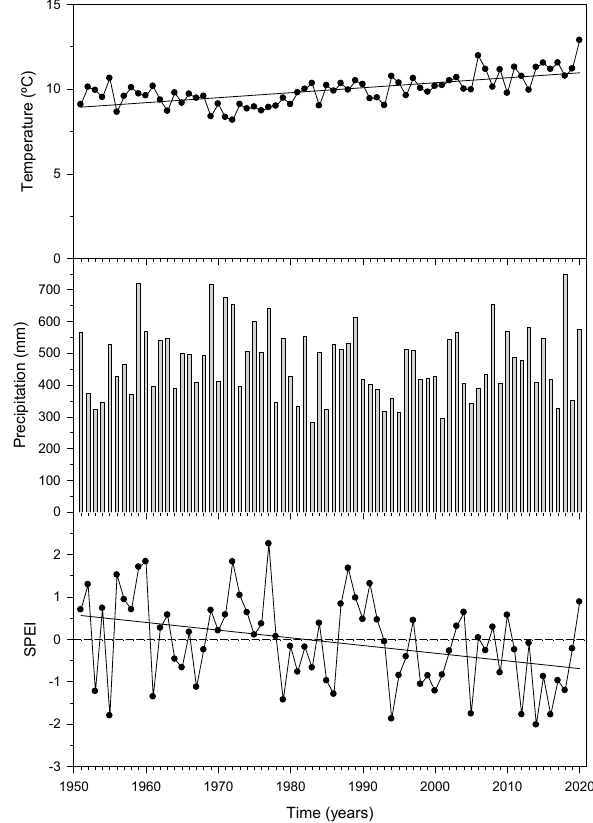
Figure 2. Annual climate (mean temperature and total precipitation) and drought trends and variability observed in the study area. The presented SPEI corresponds to July and it was calculated considering a 12-month temporal resolution. The continuous lines correspond to linear regressions fitted to temperature and SPEI data.